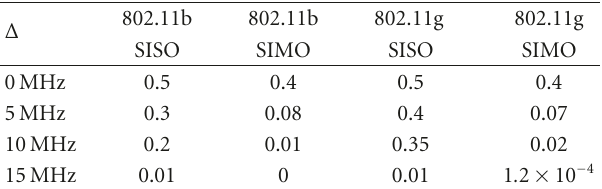
simultaneous connections with di ff erent modes on